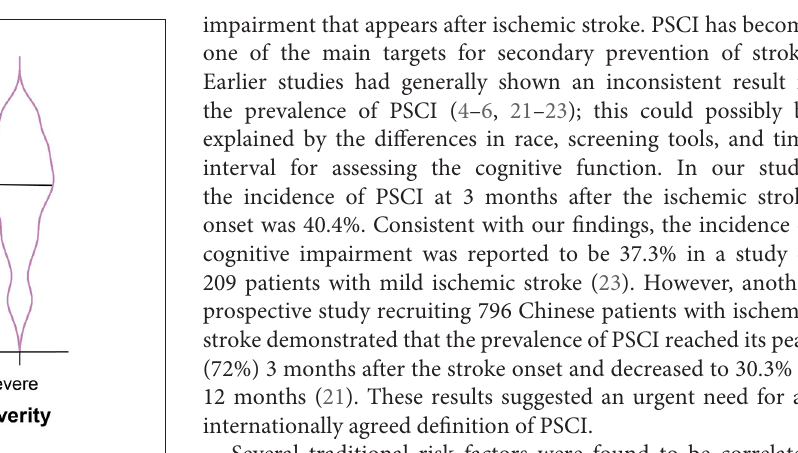
FIGURE 2 | Serum amyloid A levels and severity of cognitive impairment after ischemic stroke. The black horizontal line represents the median. The differences of serum amyloid A levels between the 3 groups of cognitive impairment severity were evaluated using Kruskal-Wallis test.